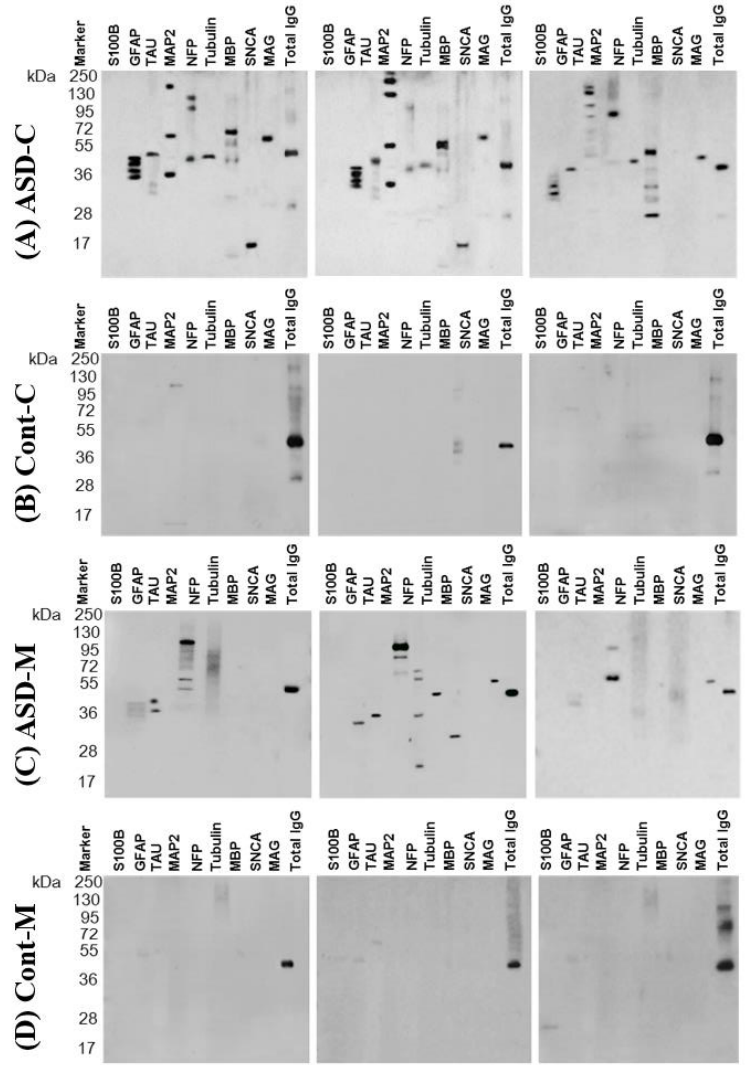
Figure 2. Representative panel of Western blotting from three cases of the (ASD-C)—ASD children ( A ), Figure 3 (Cont-C)—control children ( B ), (ASD-M)—mothers of ASD children ( C ) and (Cont-M) the mothers of control children ( D ) are shown with the molecular weight marker. Total IgG was used as a reference protein. Note that the IgG fractionates as 150 kDa on a native gel consisting of an intact IgG molecule, however, when fractionated on a denaturing gel, it resolves as two heavy (H) chains and two light (L) chains showing thick bands at 50 kDa and light bands at 25 kDa. Bands in each lane were quantified on digitized images in the mid-dynamic range and normalized to the value of IgGband